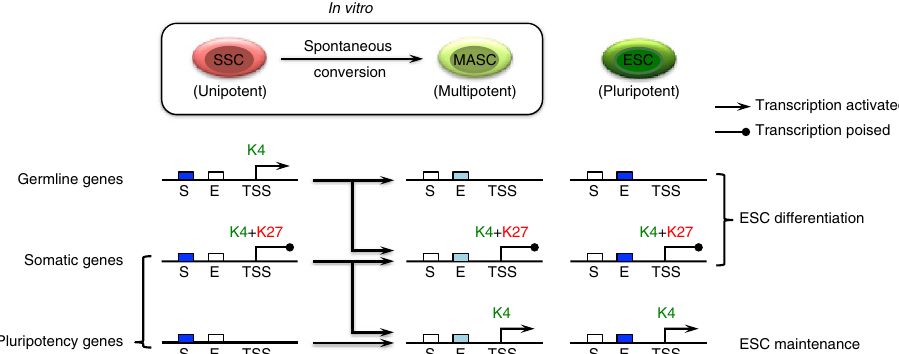
Figure 7 | Model of epigenomic changes during SSC conversion to MASC. SSC reprogramming involves changes in the epigenome at both cell-type- specific promoters and enhancers. Together with gene reactivation and silencing in reprogrammed MASCs, K4me3 modification (K4) is enriched at the promoters of pluripotency-associated genes but depleted from promoters of germline-specific genes. Conversely, K27me3 modification (K27) is erased from the promoters of many genes that are expressed in ESCs. However, K27me3 modification ‘poises’ both germline- and somatic-specific gene promoters together with K4me3 modification. At enhancer regions, MASCs are devoid of most germ cell signature enhancer activity (S) marked by K27ac modification but exhibit partially active ESC-specific enhancers (E). In summary, MASCs acquire an ESC-like epigenome at promoters and a subset of ESC-specific enhancers. Dark blue box, completely active enhancer; light blue box, partially active enhancer; white box, silent enhancer; TSS, transcription start